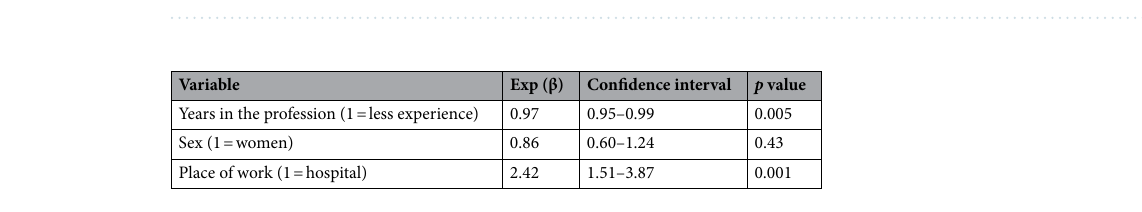
COVID-19 Critical care (ICU and intermediate care) (N =